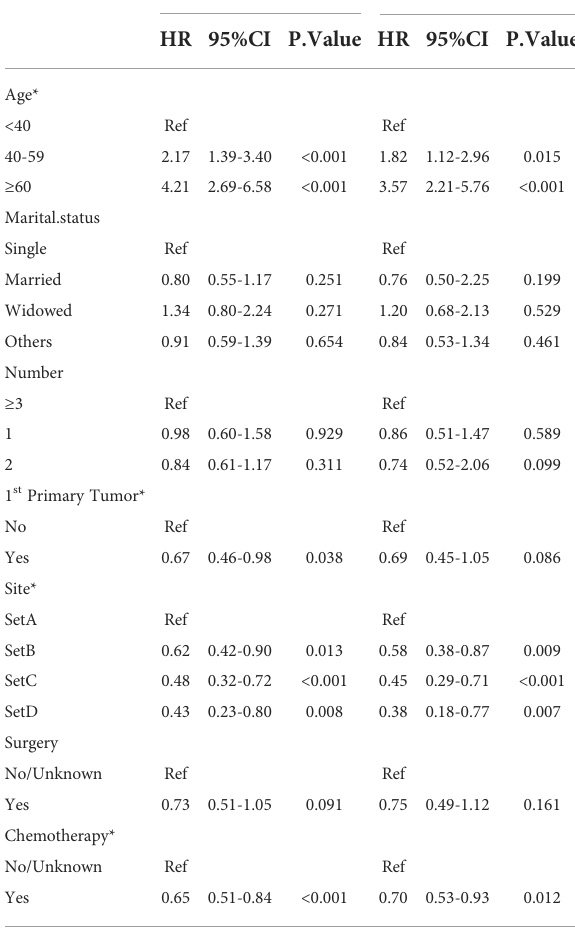
TABLE 2 Multivariate COX regression analyses of OS and CSS in the training cohort.